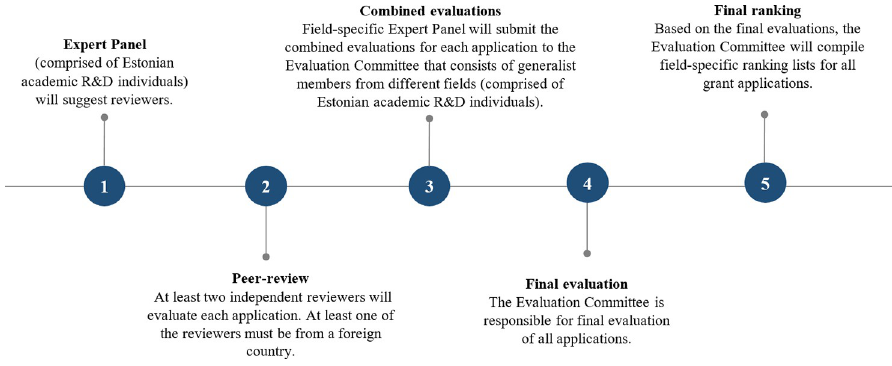
Fig 2. Overview of the evaluation process of national research grants in Estonia